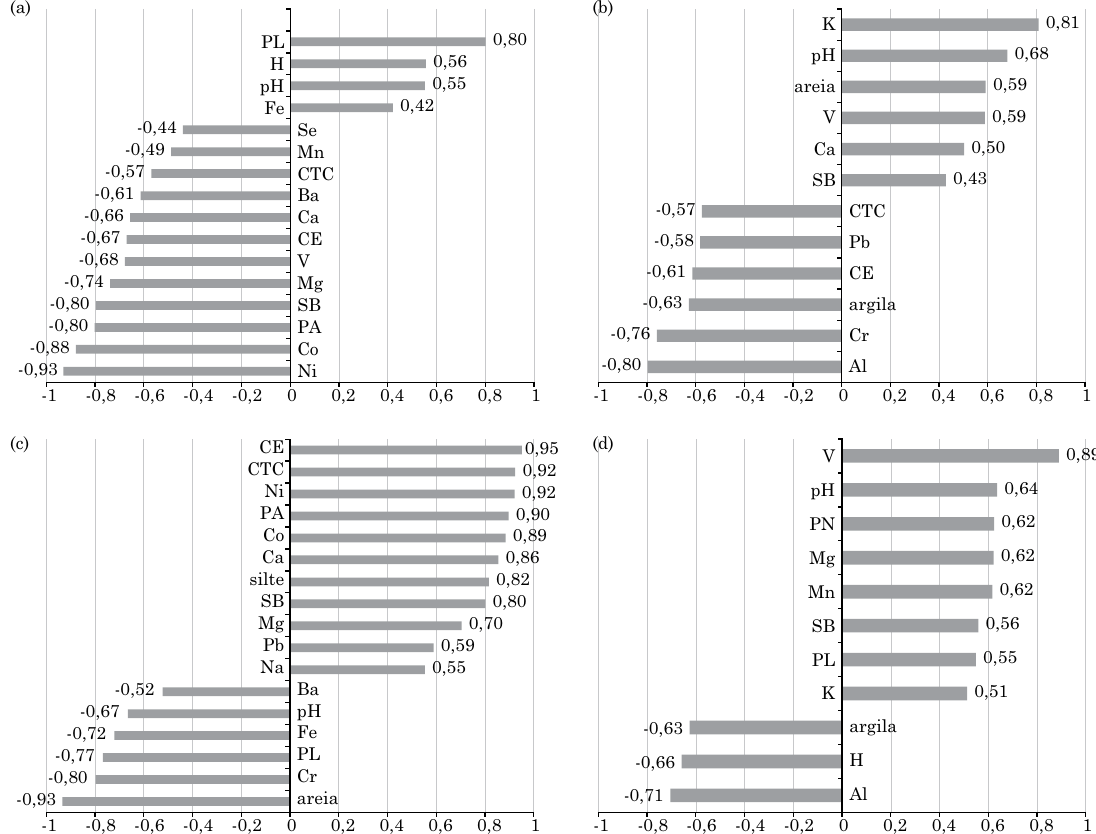
Figura 4. Coeficientes de correlação de Pearson. (a) e (b) correlações do primeiro e segundo componente principal com as propriedades do solo construído nas áreas I e II, respectivamente; e (c) e (d) correlações do primeiro e segundo componente principal com as propriedades do solo construído nas áreas IV e VII, respectivamente. As correlações exibidas foram significativas a 5